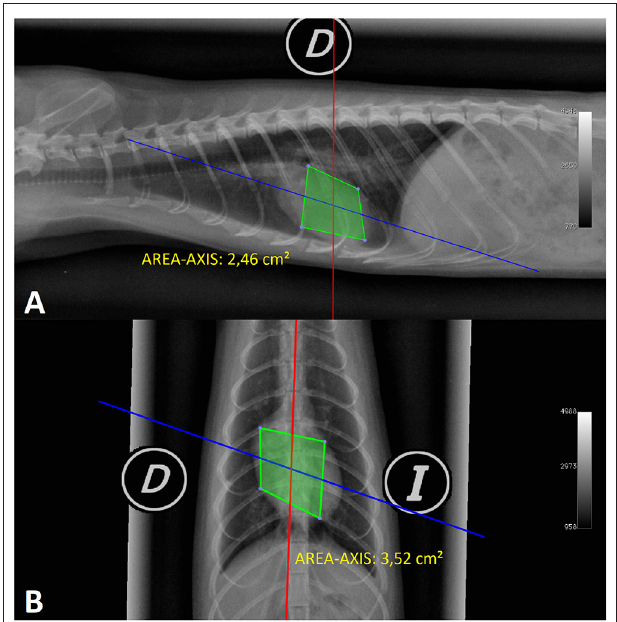
FIGURE 4 | (A) X-ray image in the right lateral projection (RL) of the normal thorax of a female ferret and (B) ventrodorsal (VD) projection of the normal thorax of a male ferret. The X-rays show a measurement of open polygon cardiac area (AREA-POL) in both projections (D, right; I,